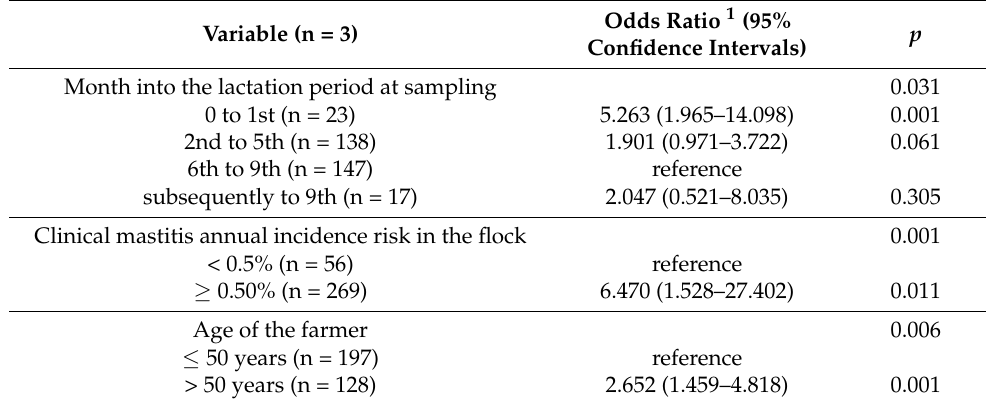
Table 5. Results of multivariable analysis for increased somatic cell counts (> 1.0 × 10 6 cells mL − 1 ) in the bulk-tank milk of 325 sheep flocks in Greece (mixed effects logistic